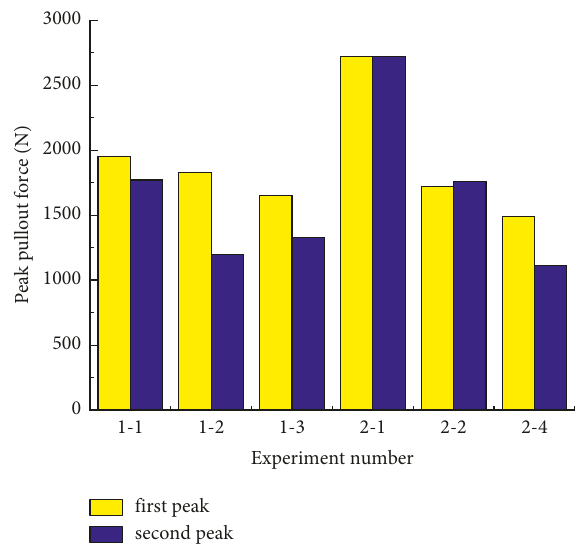
Figure 14: Comparison of peak values of clay matrix pull-out